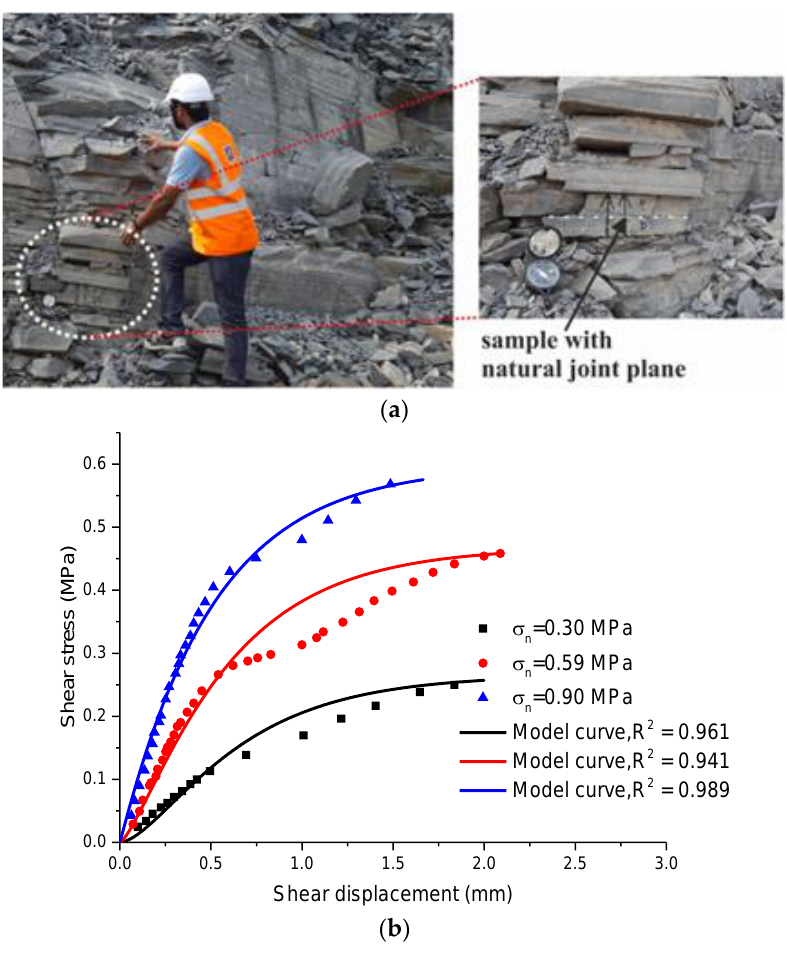
Figure 9. Comparison of in situ test results [76] with model curves, ( a ) sample collection, ( b ) shear stress - shear displacement curve.where N is the number of measured points; y test and y cal are, re- spectively, the measured stress and the theoretical stress; and y ave is the average of the y test .